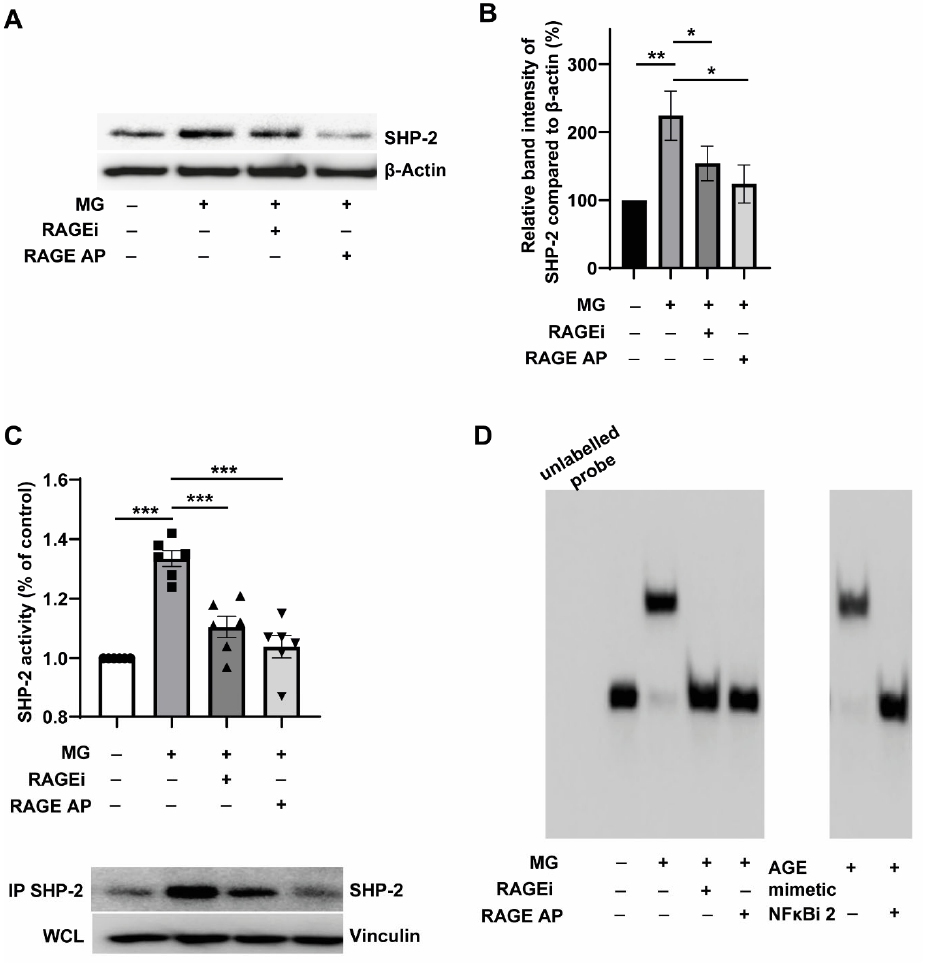
Figure 4. Genetic and pharmacological targeting of RAGE reverses MG-induced SHP-2 expression and activity through the inhibition of NFkB binding to the SHP-2 promoter. ( A ) Representative blots and ( B ) corresponding quantification. Expression of SHP-2 in relation to ß-actin. Exposure of monocytes without (black bar) or with (grey bars) 300 µ M MG for 24 h. Quantification of monocytes additionally treated with RAGE-inhibitor (RAGEi, 200 nM FPS-ZM1, Calbiochem) is shown as striped or with RAGE-antagonist peptide (RAGE AP, 2 µ M, Calbiochem) as the dotted bar. n = 8. ( C ) SHP-2 phosphatase activity assay. Monocytes were treated with 300 µ M MG for 24 h with and without RAGE-inhibitor (RAGEi, 200 nM FPS-ZM1), or with RAGE-antagonist peptide (RAGE AP, 2 µ M). Thereafter, the cells were lysed in anoxic conditions and the phosphatase activity was measured in the SHP-2 immunoprecipitates using the Tyrosine Phosphatase Assay System (Promega). The SHP-2 levels in the immunoprecipitates were detected using Western Blot (lower panel). n = 6. ( D ) Electrophoretic Mobility Shift Assay (EMSA) assay. Monocytes were exposed to 300 µ M